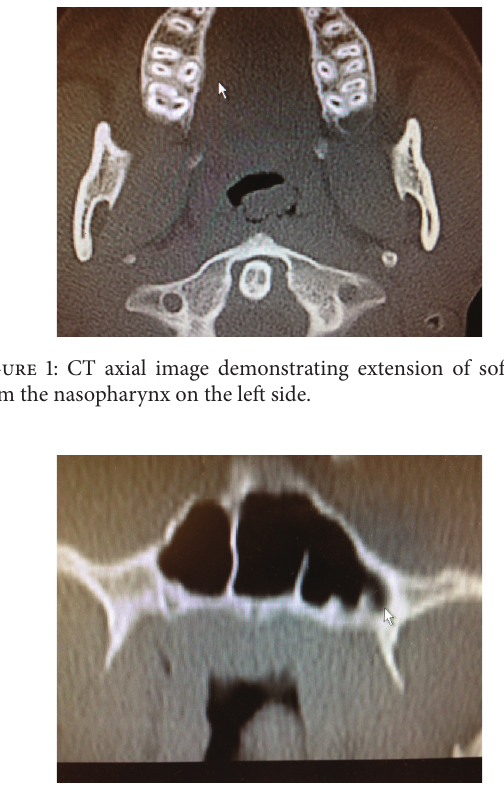
Figure 2: CT coronal image demonstrating a nasopharyngeal